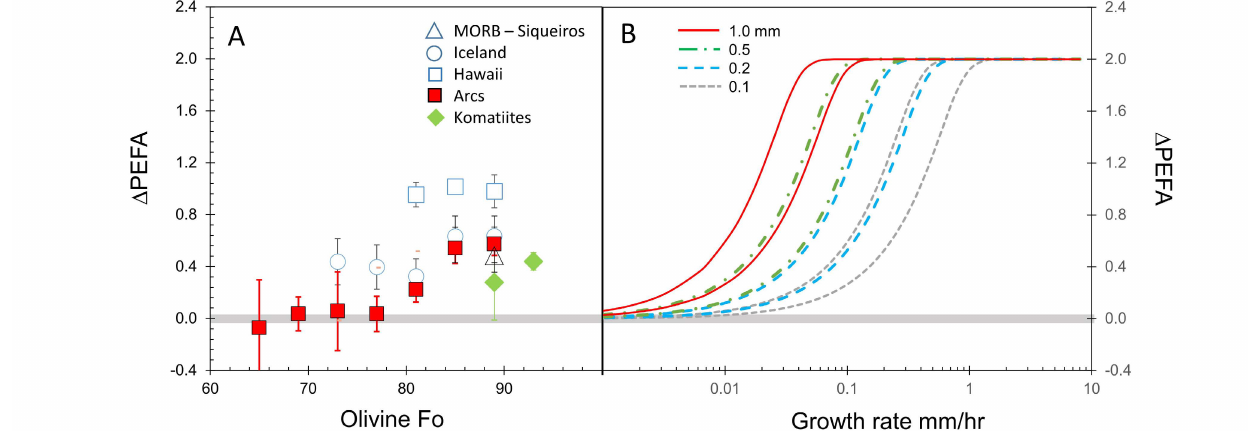
Figure 7: [A] Deviations from PEFA in units of Δ PEFA for olivines from different magmatic environments. Δ PEFA values represent the mean over 2 units of forsterite. Vertical error bars represent 3 standard errors of the mean, where standard error is the standard deviation divided by the square root of the number of samples. [B] Results of crystal growth models, where the extent of disequilibrium as represented by Δ PEFA is plotted against crystal growth rate. Colors represent different assumed boundary layer thicknesses in the melt. For a given color (boundary layer thickness), left line corresponds to P diffusivity at 1180 °C and right line at 1250